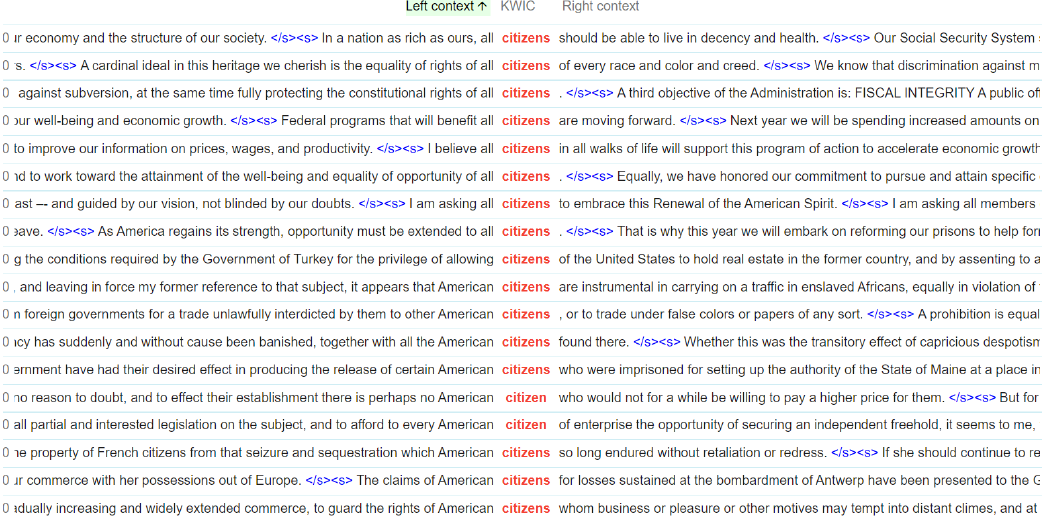
Figure 2. Sample of the concordance of citizens in the SoU corpus, sorted alphabetically one word to the left.